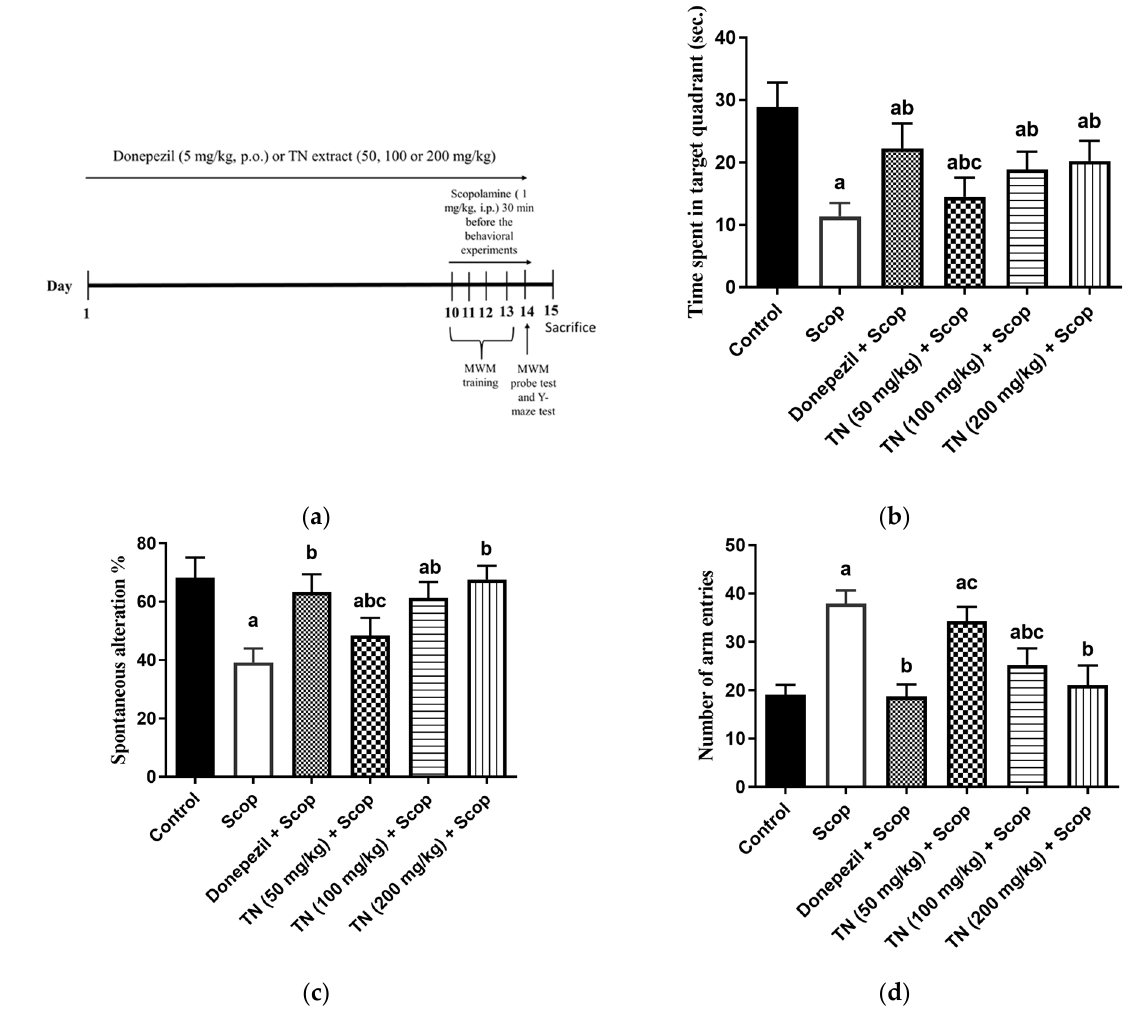
Figure 2. Experimental timeline ( a ). Effect of different doses of TN on the time spent in the target quadrant during the probe trial session in the MWM ( b ). Percentage of spontaneous alternation ( c ). Number of arm entries ( d ) in the Y maze test. Values are expressed as the mean ± SD ( n = 15). Values are statistically significant at p < 0.05 versus the control group, p < 0.05 versus the Scop-treated group and p < 0.05 versus the donepezil-treated